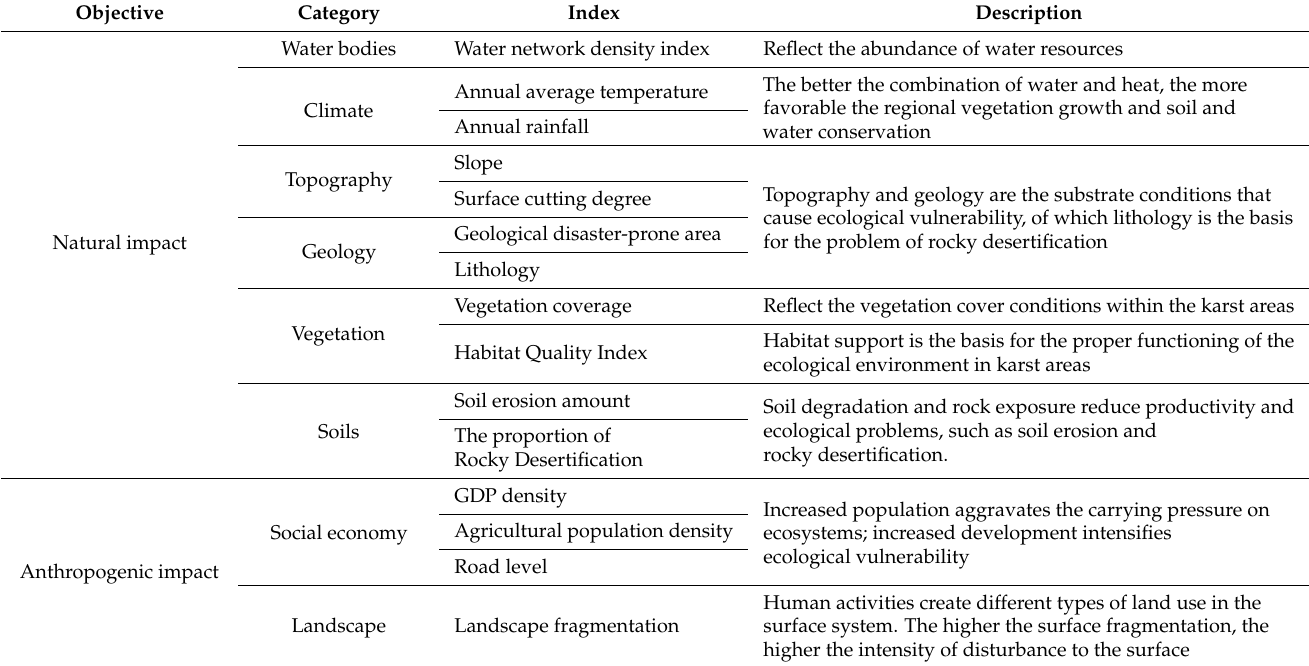
Table 2. Index system of ecological